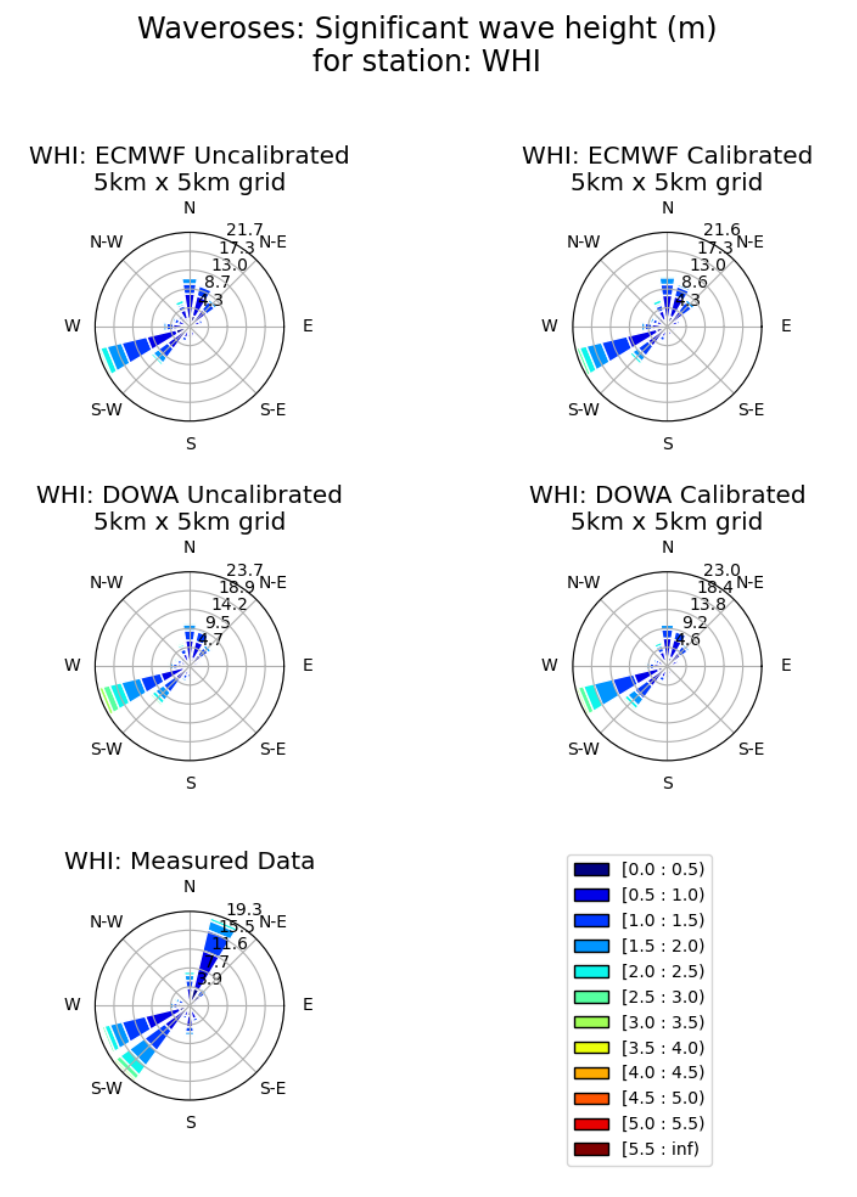
Figure 6. Wave roses (significant wave height) for the 5 km computational grid showing the measured data, the calibrated and uncalibrated SWAN models forced with the ECMWF-ERA5 and DOWA wind